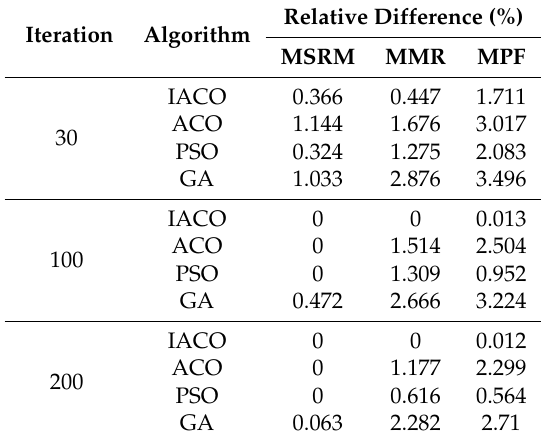
Table 2. Optimal